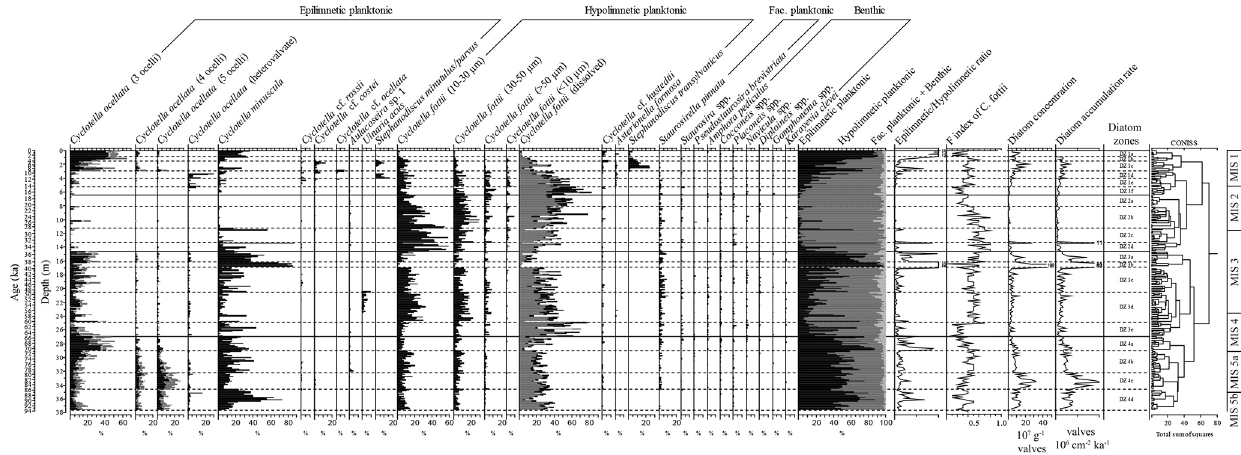
Figure 2. Stratigraphic diatom diagram showing species with > 2% abundance in Lake Ohrid DEEP site core 5045-1, F index of Cyclotella fottii , diatom concentrations ([ n ] valves × 10 7 g − 1 dry sediment) and diatom accumulation rates ([ n ] valves × 10 6 cm − 2 ka − 1 ). Diatom zone boundaries are defined by CONISS, Marine Isotope Stages (MIS) boundaries after Lisiecki and Raymo